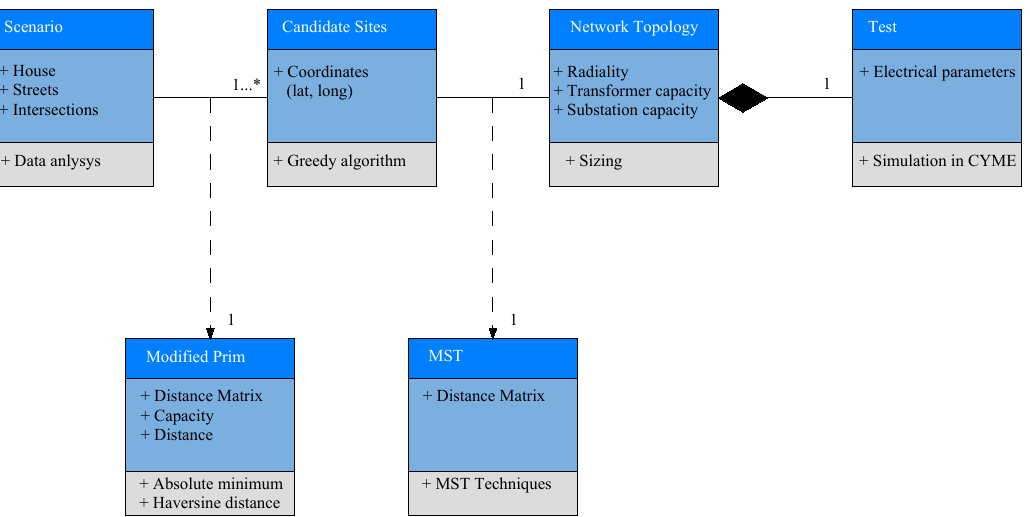
Figure 2. Scheme of model to solve the network reconfiguration.